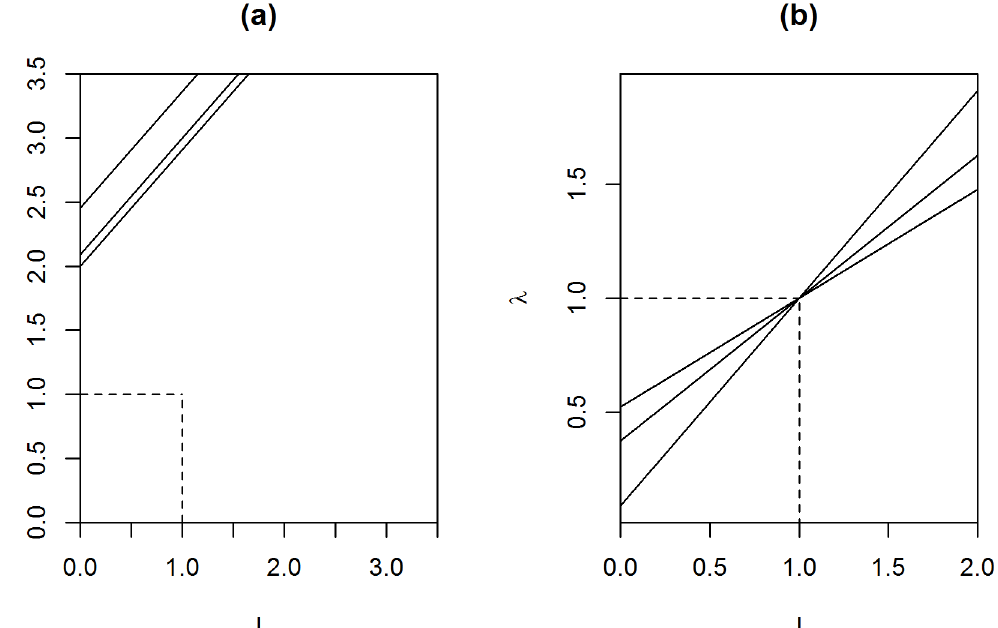
Fig 3. Linear shrinkage of the eigenvalues. Shrinkage of the eigenvalues of the MAP of the covariance matrix, as r is fixed and α changes when n < p (a) and with α = r − p − 1 as the sample size n increases (b). The x-axis denotes the eigenvalues of the MLE ( l ) and y-axis denotes the corresponding eigenvalues of the posterior estimate ( λ = Φ ( l ) − 1